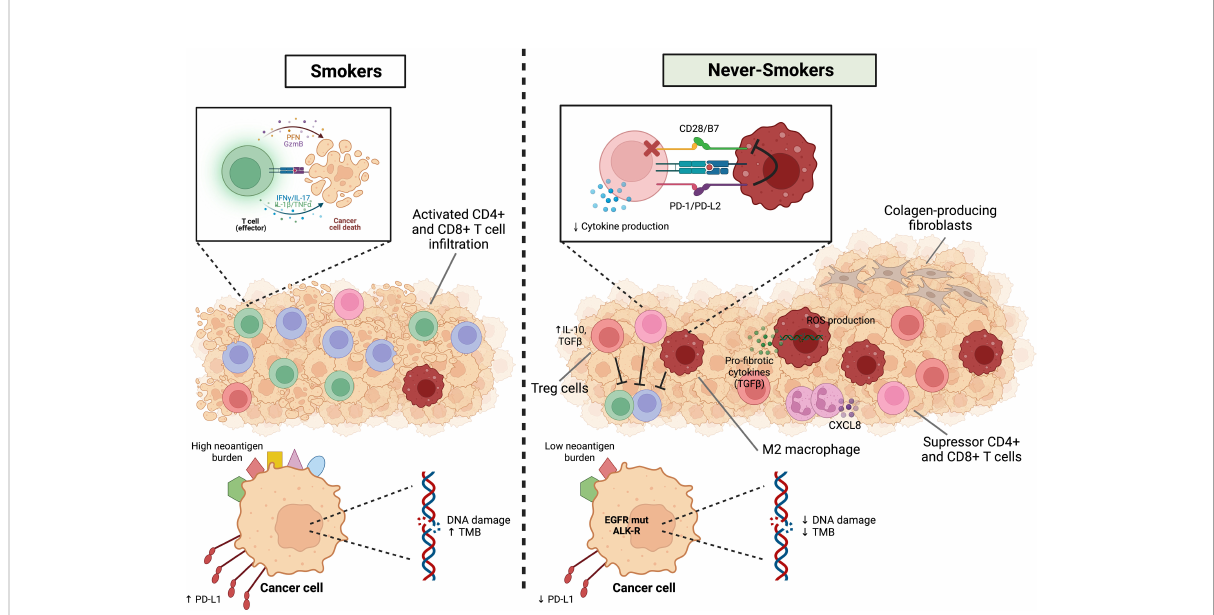
FIGURE 2 Immune landscape in smoker and never-smoker lung cancer patients. NSCLCs from smokers have high TMB and a higher mutational smoking signature and neoantigens generation are associated with higher levels of immune in fi ltration, higher production of in fl ammatory cytokines such as IL-1beta and IL-17, higher cytolytic activity and interferon-gamma pathway signaling. On the other hand, the immune microenvironment of the non-smoking group is signi fi cantly enriched for immunosuppressive related cells, including Treg cells, suppressor CD4+ or CD8+ T cells and M2 macrophages. In addition to the lower expression of PD-L1, the interaction between PD-L2 (APCs) and PD-1 (T cells) inhibits strong B7-CD28 signals and reduces cytokine production. In particular, air pollution and oxidative stress can lead to DNA damage and ROS release by resident lung macrophages and subsequent immunopathology and tissue damage. Macrophages can be a source of proin fl ammatory, and pro- fi brotic cytokines and neutrophils play a role in chronic in fl ammation in general (CXCL8). Finally, fi broblasts respond to excessive and aberrant wound healing by entering hyperproliferation and change to a pro- fi brotic phenotype resistant to apoptosis. Figure designed using